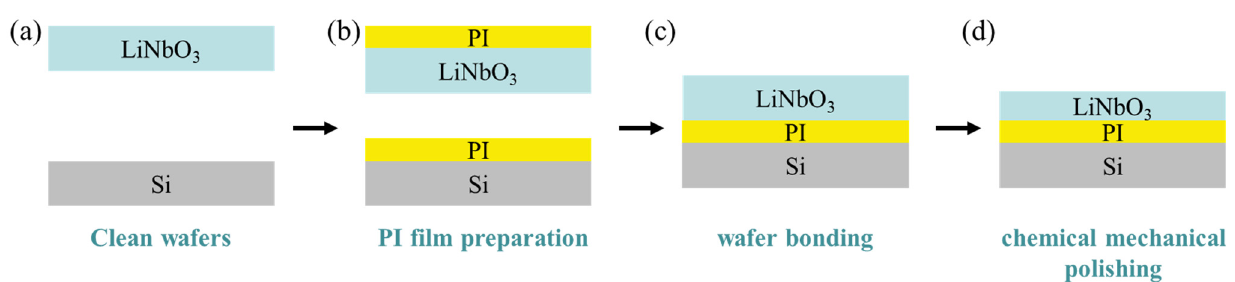
Figure 1. Integration processes of wafer-level LiNbO 3 single-crystal thin film on silicon: ( a ) wafer cleaning, ( b ) preparation of PI film on LiNbO 3 and Si, ( c ) LiNbO 3 substrate and Si substrate bonding, and ( d ) thinning procedure of LiNbO 3 by CMP.